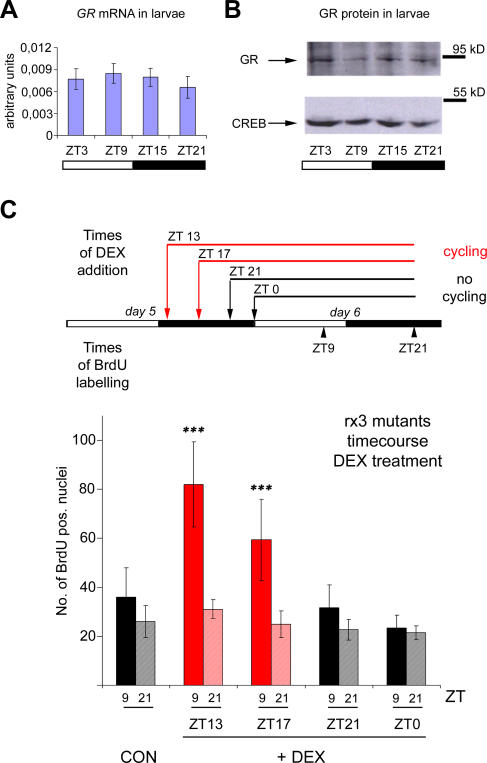
Shorter-Term Treatment with Dexamethasone Also Rescues Cell Cycle Rhythms in Strong rx3 Mutants(A and B) Expression analysis of the zebrafish GR. (A) GR mRNA expression as determined by quantitative RT-PCR in wild-type larvae at four circadian time points. No significant oscillation is apparent (one-way ANOVA [analysis of variance], p = 0.4231). Error bars show the 95% confidence interval of the mean from three independent experiments. As a control, per4 mRNA levels were assayed in the same samples and shown to exhibit a high-amplitude rhythm (unpublished data; see also Figure2A). (B) Representative Western blot showing expression levels of the GR protein (upper) and of CREB (lower) as a loading control. Consistent with mRNA expression levels, no overt oscillation can be observed.(C) Upper panel: experimental design to define a minimum period of exposure to the tonic dexamethasone (DEX) signal required to rescue cell cycle rhythms in the rx3 mutants. Black and white bars represent the light and dark periods of day 5 and 6 post-fertilization. Above: times of DEX addition to the medium. Red arrows and lines indicate treatments that are able to increase the cycling amplitude of BrdU incorporation in strong rx3 mutant larvae, whereas black arrows and lines indicate those that fail to do so. Below: times for BrdU labeling (as 15-min pulses) and harvesting on day 6 (indicated as ZT time points).Lower panel: quantification of BrdU incorporation in strong rx3 mutants following the treatments outlined in the upper panel. Peak (ZT9, dark color) and trough (ZT21, light color) mean values on day 6 are shown for untreated controls (CON) and the four times of DEX addition on day 5 (+DEX). Red bars: treatments that result in a significant difference between peak and trough values (Mann-Whitney-Test; ***, p < 0.001), black bars: no significant differences observed between peak and trough values. Error bars indicate the 95% confidence interval of the mean. Data are pooled from six independent experiments.